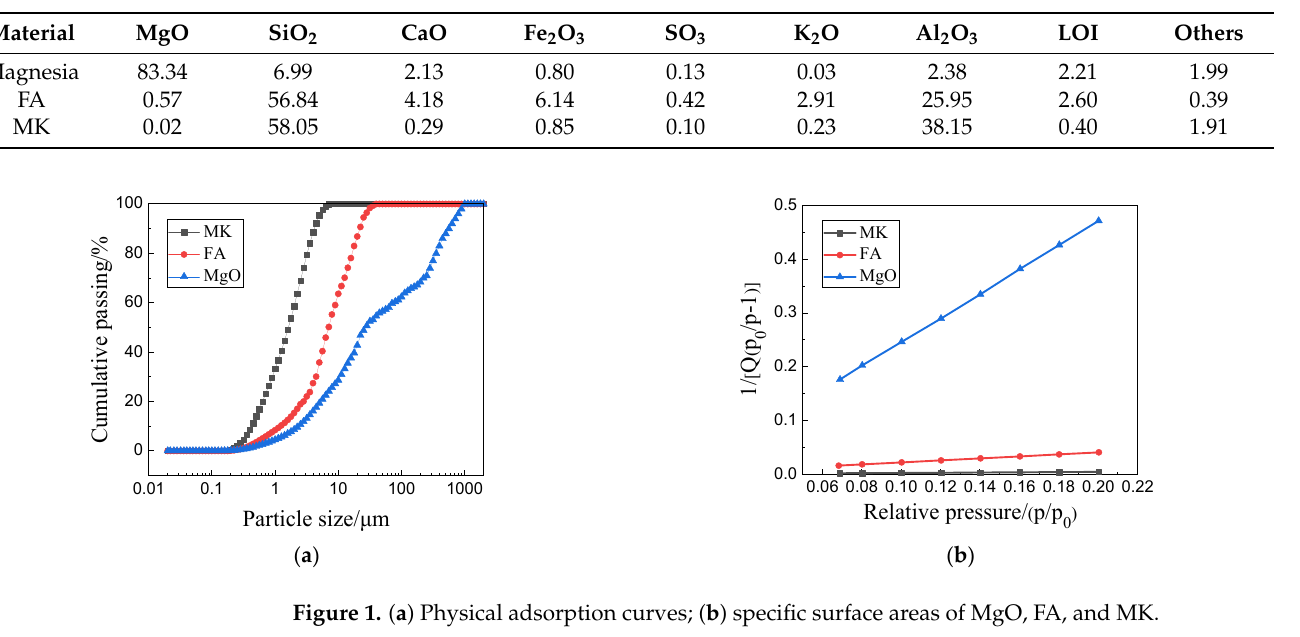
Table 1. Chemical composition of precursor materials: magnesia, FA, and MK (%).